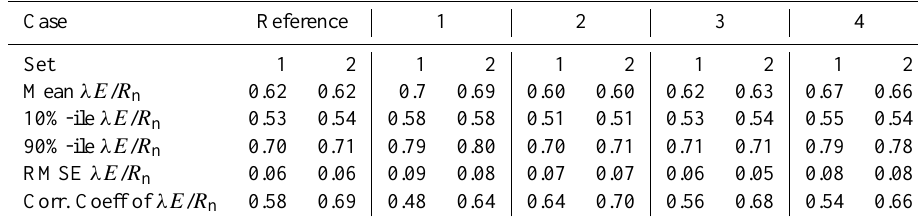
Table 4. Summary statistics of the evaluated